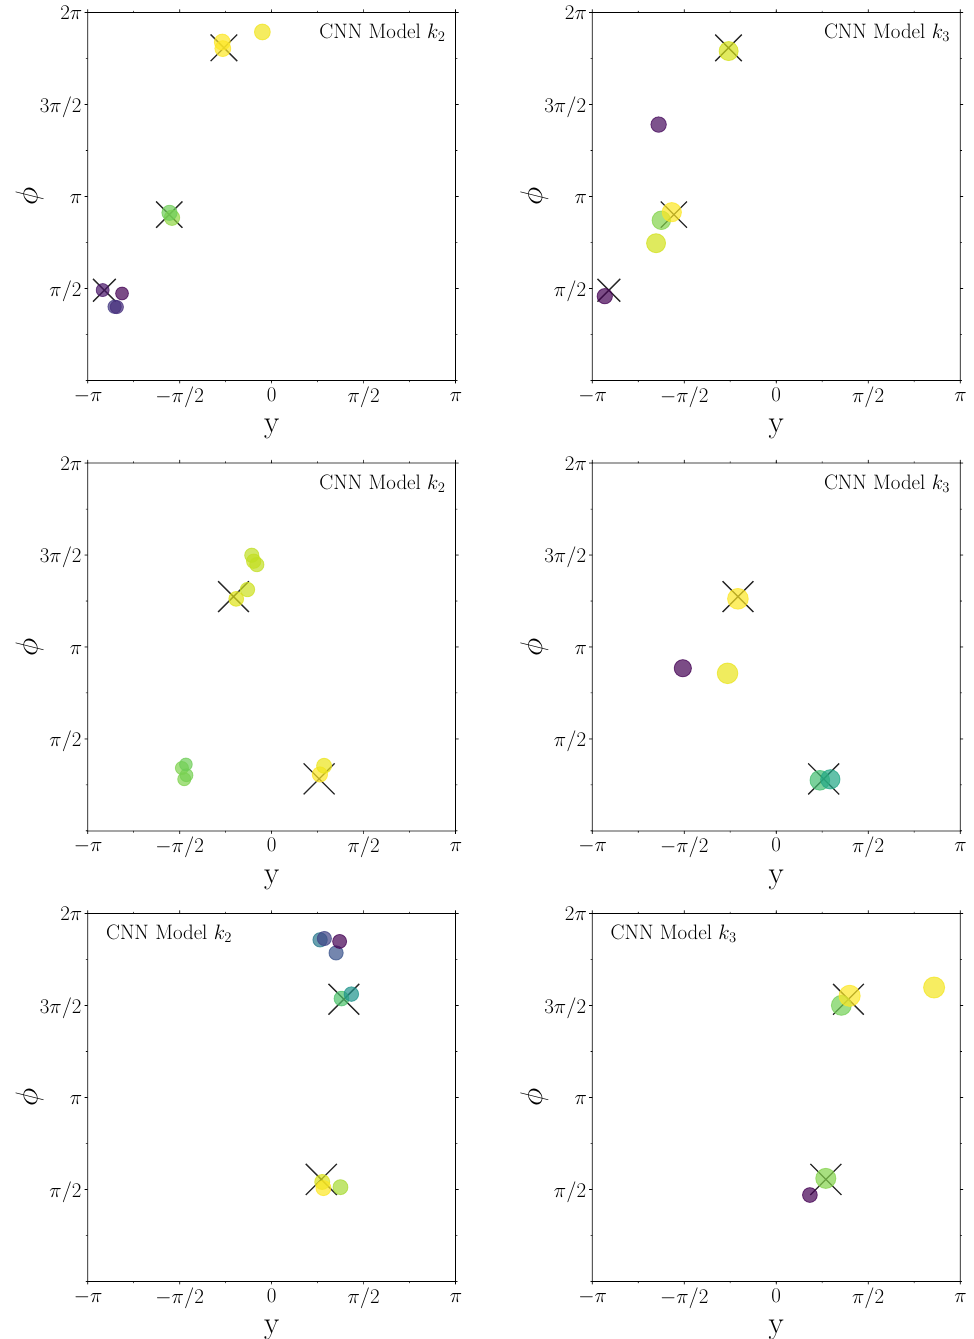
Figure 5 . Three example emission patterns generated by the k 2 (left column) and k 3 (right column) CNN models. The coloured circles indicate the location of emitted particles, and the sizes and colours of the circles indicate the particle p T . The grey Xs in each plot are the matrix element emissions that are input to the CNN.